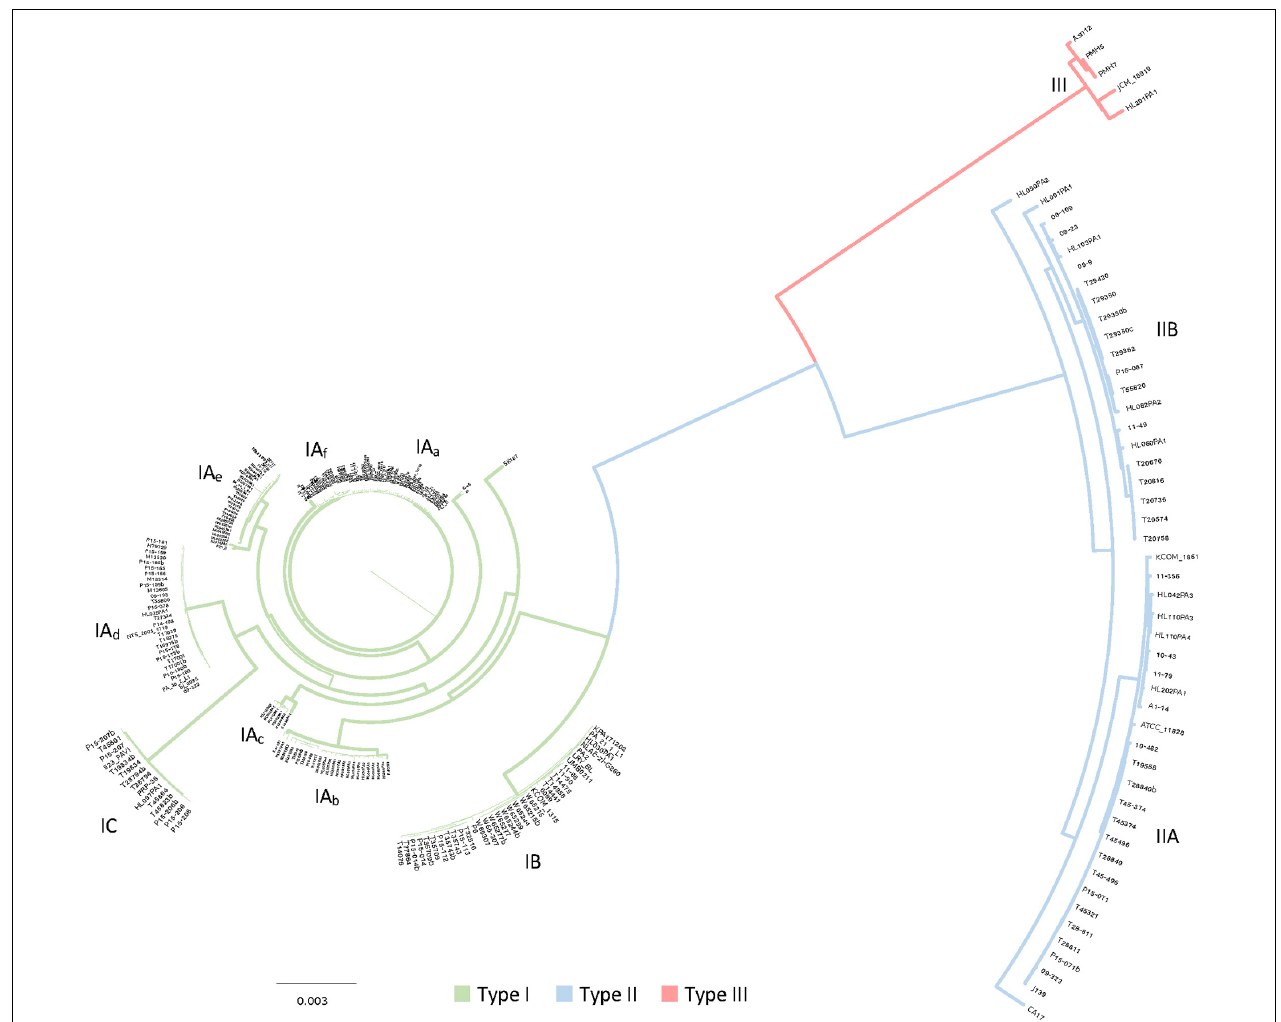
FIGURE 3 | Core genome based phylogenomic tree with the 1,194 core genes detected in the 255 C. acnes strains. The main clades of strains were identified, and color coded in the branches for type I, type II and type III, with green, blue and red respectively. Sub-clades within the type I (IA, IB, and IC) and type II clades (IIA, IIB) were also identified, together with six sub-groups within the sub-clade IA, labeled as IA a to IA f